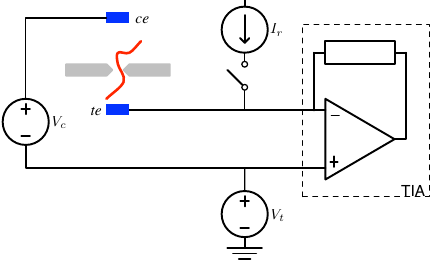
Figure 11. Basic electrical configuration employed in a nanopore test